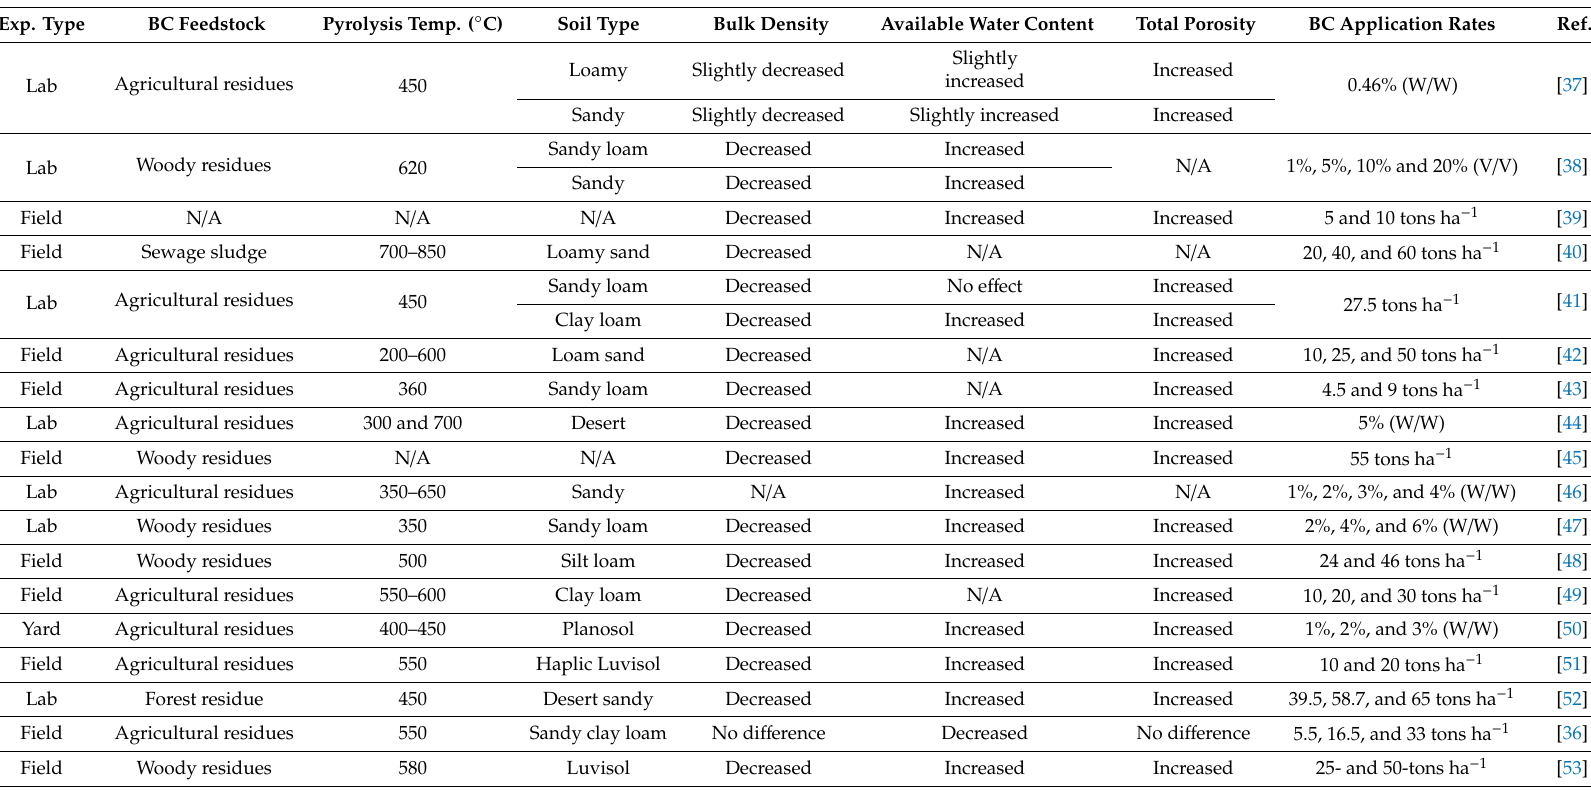
Table 1. A summary of recent studies related to the impact of biochar on physical properties of soil. The soil types listed in this table correspond to the types reported in the original publication. The usage of term ‘slightly’ in any of the categories indicates a change in mean values. BC: biochar. Exp.